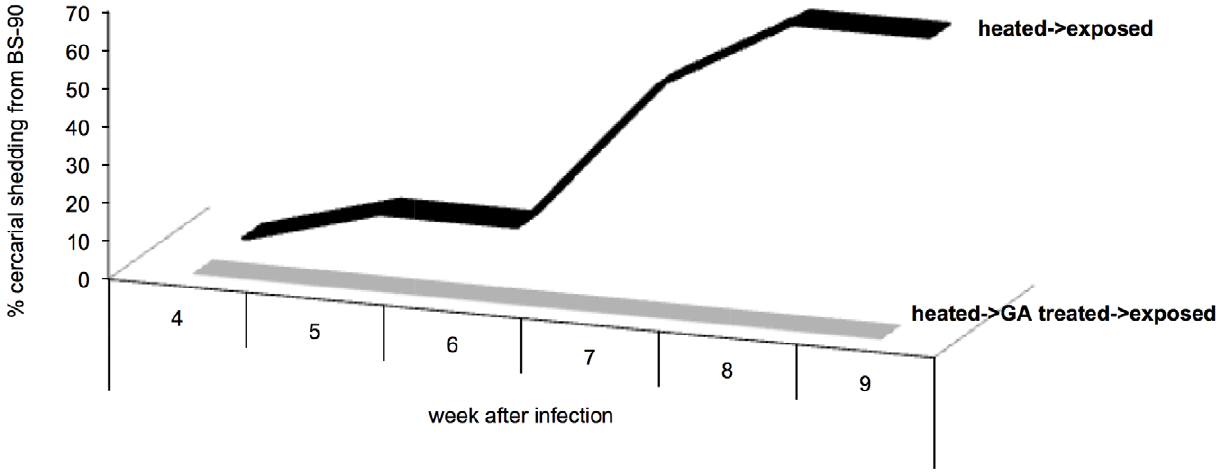
Figure 5. Percentage cercarial shedding from heat-pulsed resistant BS-90 snails that were either treated ( + GA), or untreated ( 2 GA) prior to S.mansoni exposure. Note that the snails that were not treated with GA but heat- pulsed and exposed began to shed cercariae at 4 weeks PE (with 70% shedding parasites at 9 weeks PE). In contrast, note that the heat -pulsed- GA-treated - infected snails remained negative for the entire 9 weeks duration of the experiment.